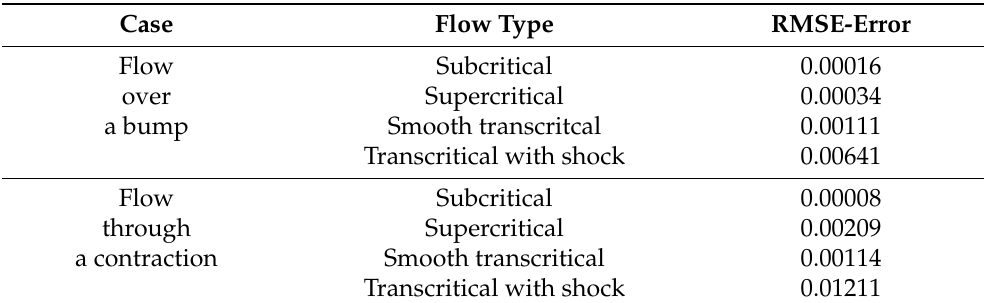
Table 1. The root mean square error (RMSE) between the numerical fluid height and the analyti- cal